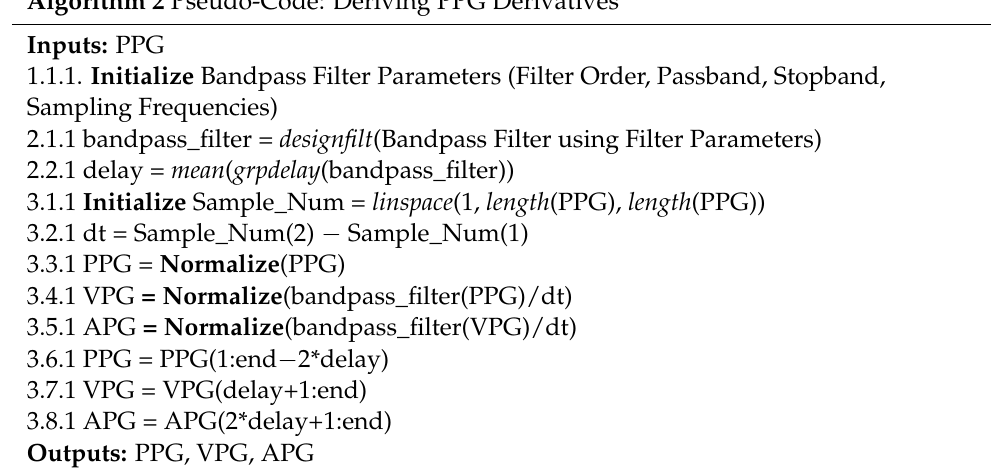
Algorithm 2 Pseudo-Code: Deriving PPG